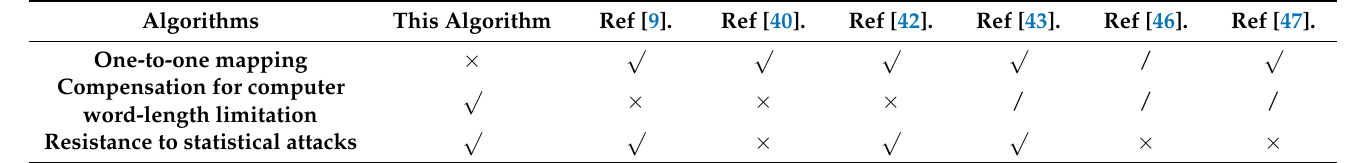
Table 3. Comparison with existing